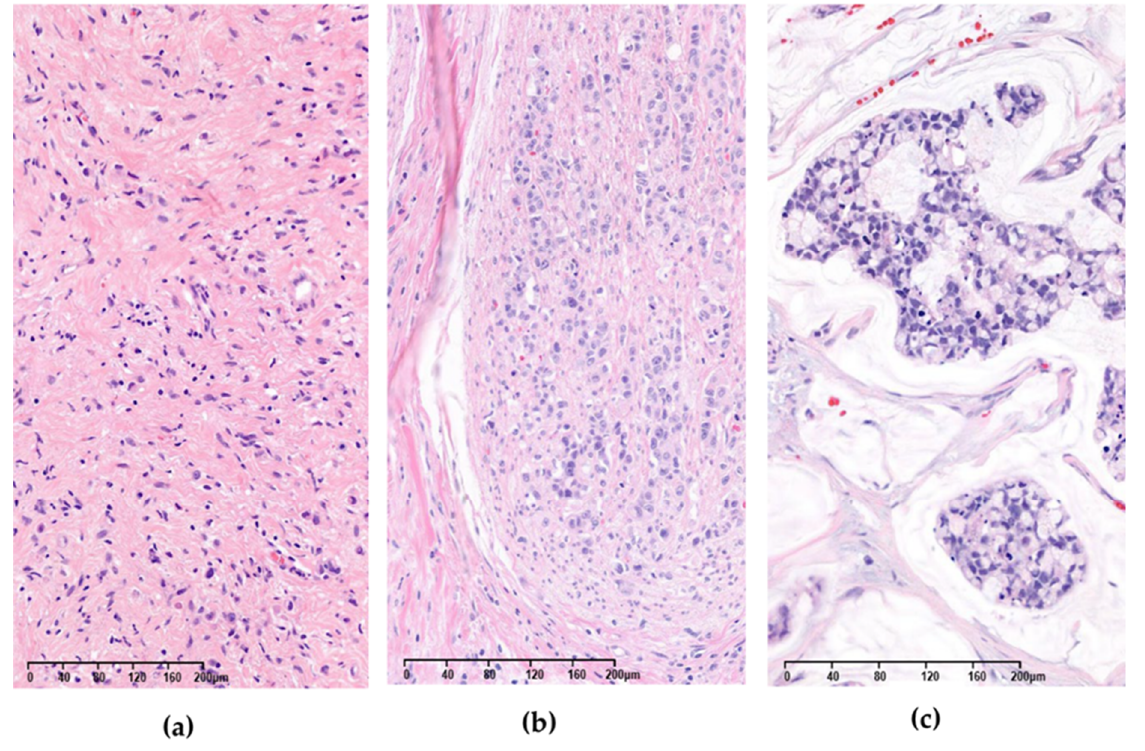
Figure 1. Three different gastric adenocarcinoma cases with FGFR2 amplification (hematoxylin and eosin stain). Copy numbers of each case were ( a ) 9.1 (ID 205); ( b ) 9.2 (ID 253); and ( c ) 64 (ID 242), respectively.